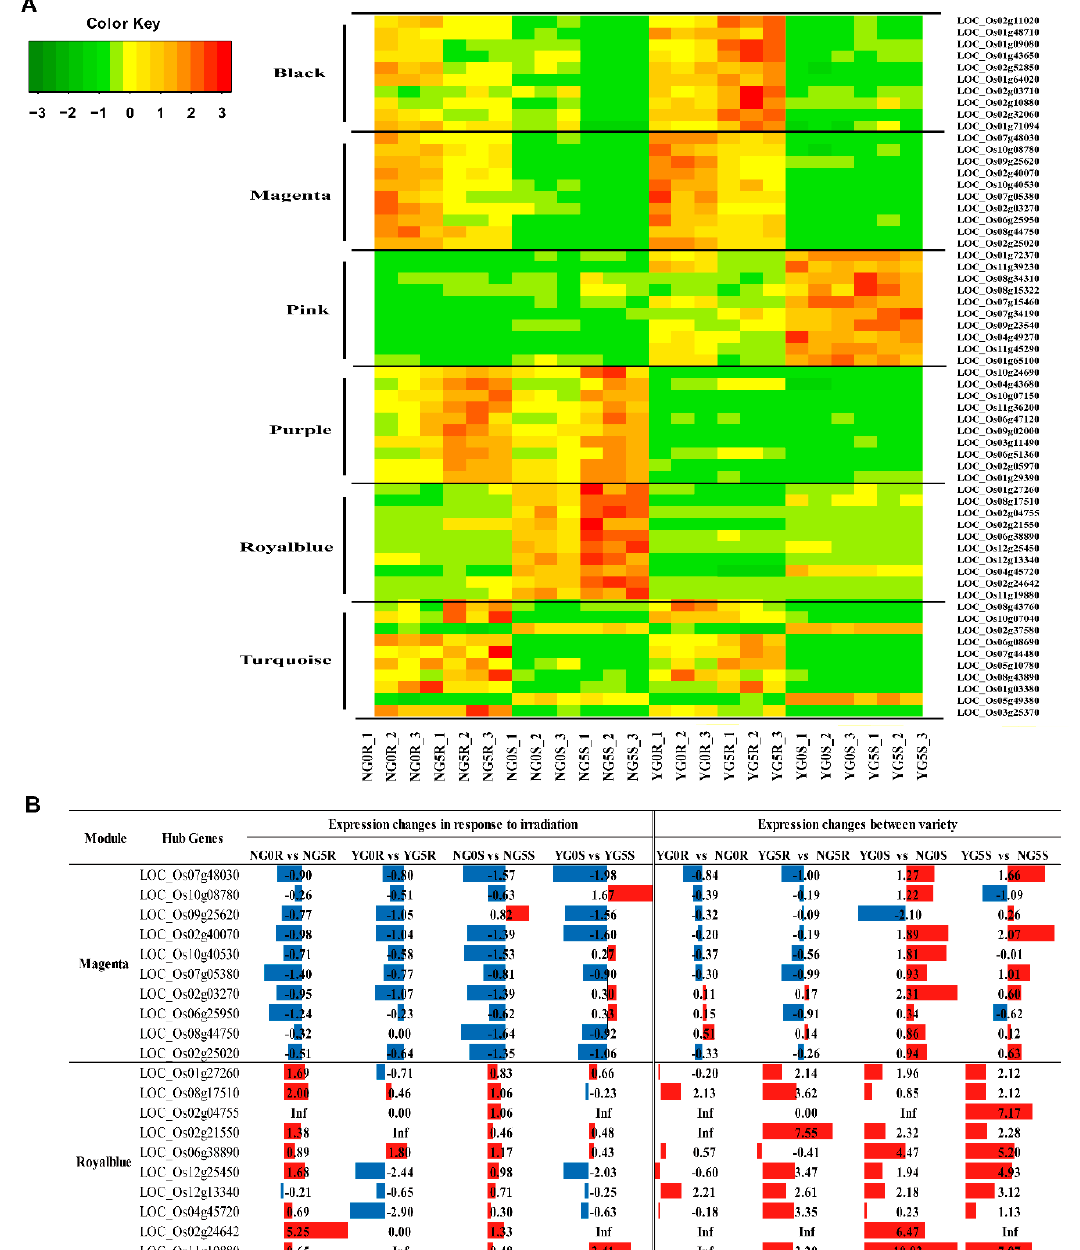
Figure 9. Gene expressions of top ten node genes of six related modules. ( A ) Heatmap comparison showing the expression profiles of top ten node genes in each module; ( B ) Changes in the expression levels of hub genes in top ten node genes of magenta module and royal blue module.